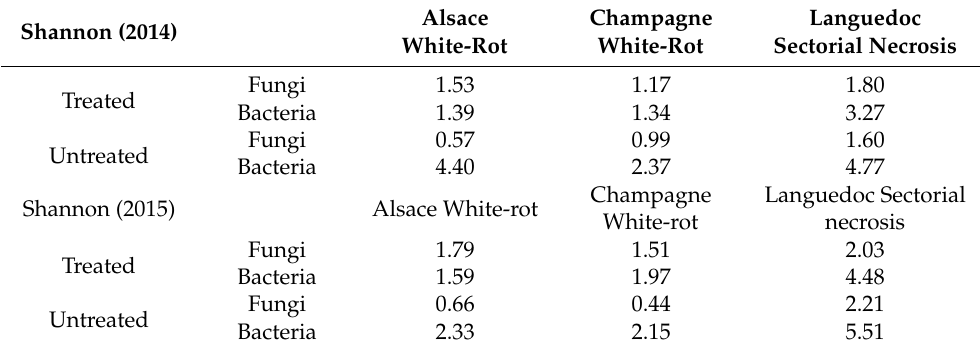
Table 2. Taxonomic diversity fungal and bacterial microbiota from woody tissues of grapevines sampled in 2014 and